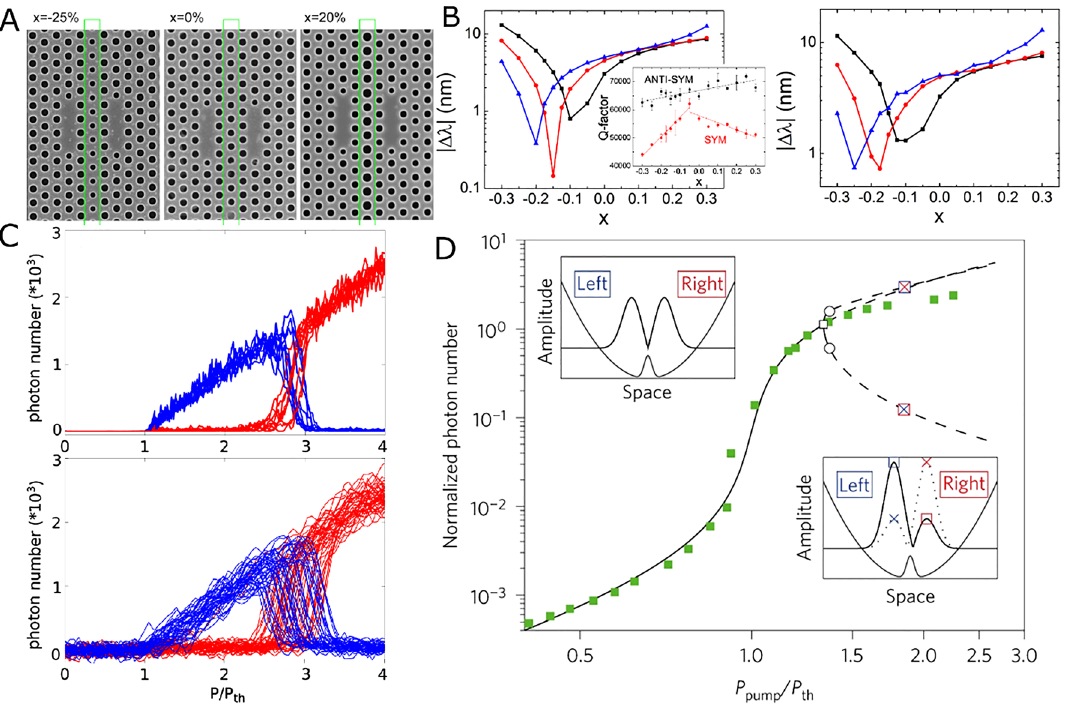
Figure 3: Mode selection and switching. (A) Barrier engineering in photonic crystal nanolasers by changing size of the middle row of holes. For the case of x = 0%, the radius of the highlightedrowofholesis ∼ 115nm.(B)Absolutevalueof wavelengthdifferencebetweenBandABmodes – | Δ λ | – vs.sizeofthemiddlerowof holes. Simulations (left) and experiment (right). Different colors represent different cavity sizes. The dip corresponds to the crossing or transitionpointwhereABmodegoesfrombeingtheexcitedstate(rightofdip)tobecomingthegroundstate(leftofdip);theoppositeistrueof the B mode. (A) and (B) adapted and reprinted from a study by Haddadi et al. [47] with permission. (C) Simulated (top) and experimental (bottom)resultsshowingswitchingfrom B(blue)to AB (red)mode dueto increasedpumppowers intwo coupledphotoniccrystal nanolasers. Adapted from a study by Marconi et al. [50] with permission. (D) LL curve of two coupled photonic crystal nanolasers (green fi lled squares- experimental results; black solid line-numerical simulation) showing pitchfork bifurcation that results in two coexisting and stable, broken parity states (right inset). Left inset: Stable solution before bifurcation. Adapted from a study by Hamel et al. [36] with